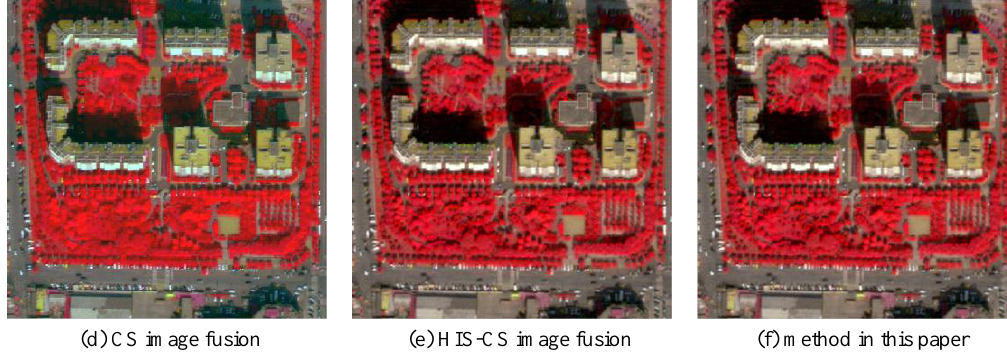
Fig 4 The results of different fusion methods